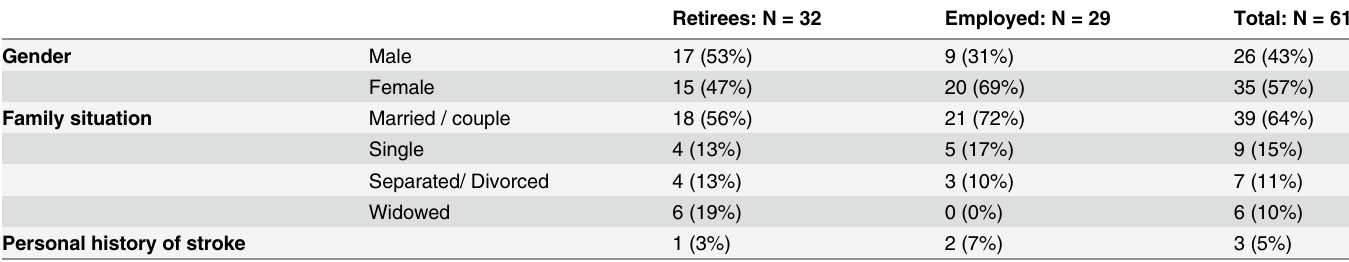
Table 2. Characteristics of study participants